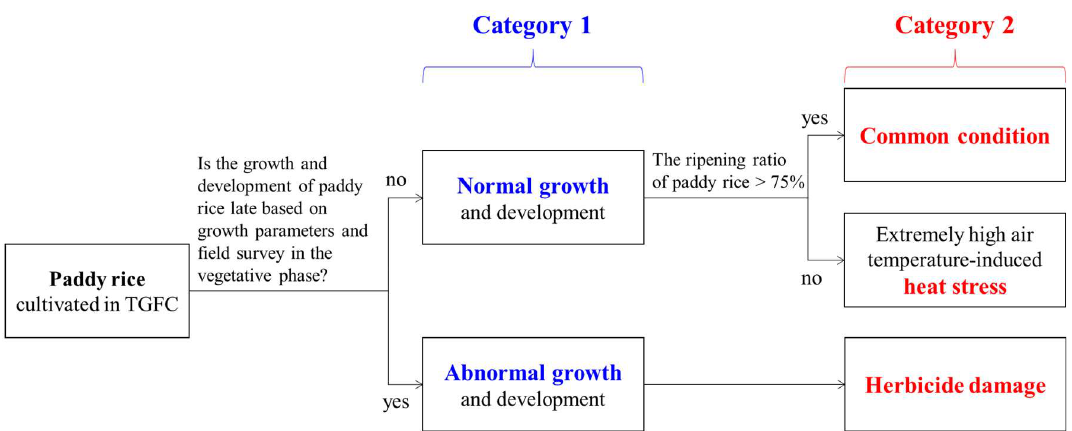
Figure 2. Stress category in this study. Category 1 was classified as normal and abnormal growth and development stats. Normal growth was sub-divided as common condition and heat stress stats in Category 2.